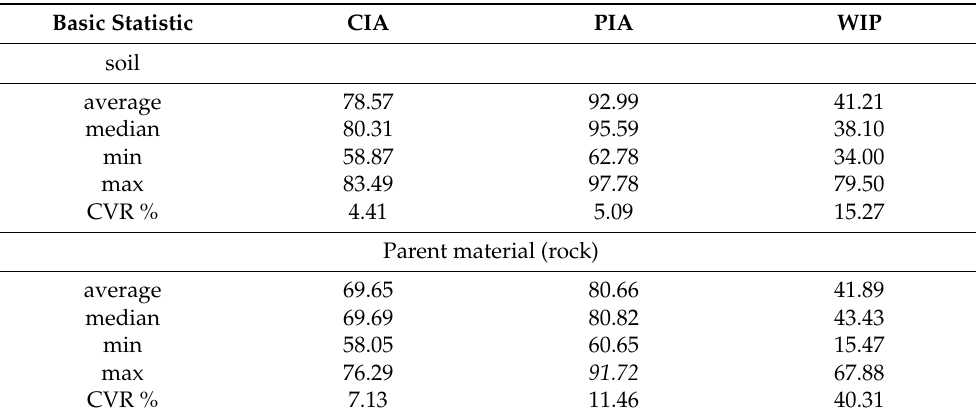
Table 5. The weathering indices for soil and parent material.